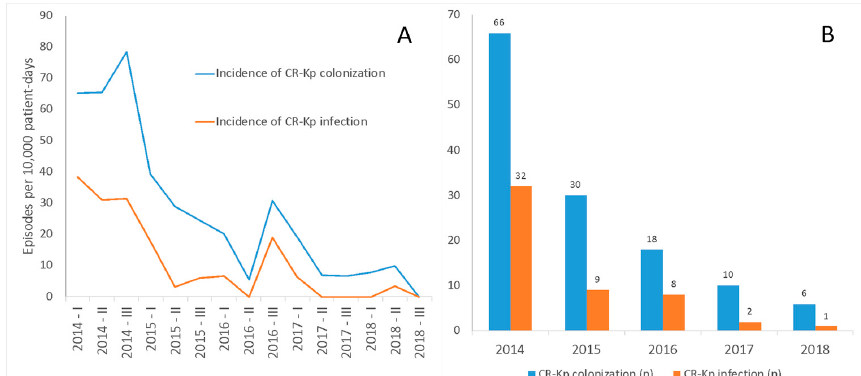
Figure 1. Trends in the incidence of colonization and infection by carbapenem-resistant Klebsiella pneumoniae (CR-Kp) in cardiac surgery patients over the study period. Panel A: Changes over quadrimesters in the incidence of CR-Kp colonization (incidence rate ratio (IRR) 0.82, 95% confidence intervals (CI) 0.78–0.86, p < 0.001) and CR-Kp infection (IRR 0.76, 95% CI 0.69–0.83, p < 0.001) were assessed through univariable, generalized linear models based on negative binomial regression (see study methods). Panel B: Number of episodes of CR-Kp colonization and CR-Kp infection during the